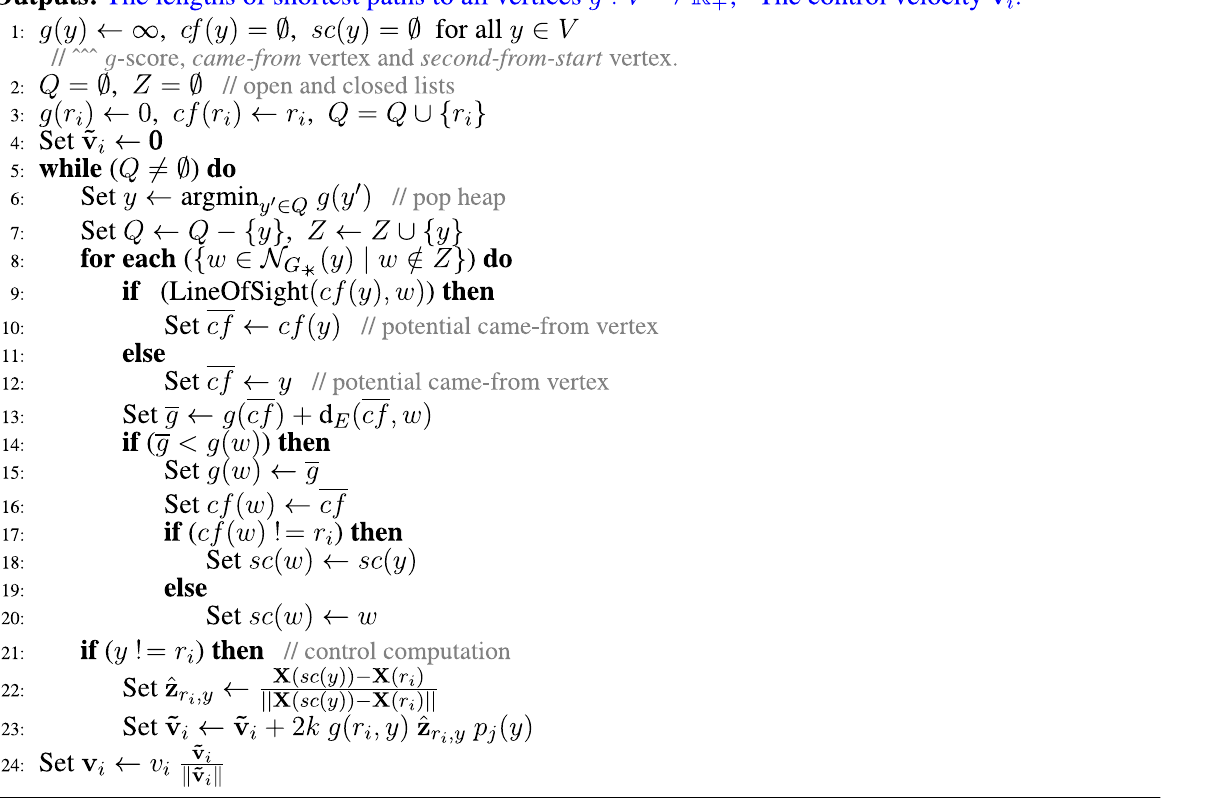
Frontiers in Robotics and AI |